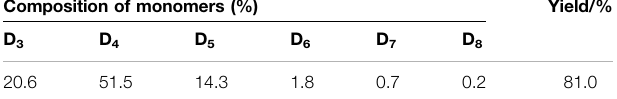
TABLE 2 | Yield and composition of monomers obtained from biodegradation. Composition of monomers (%) Yield/%